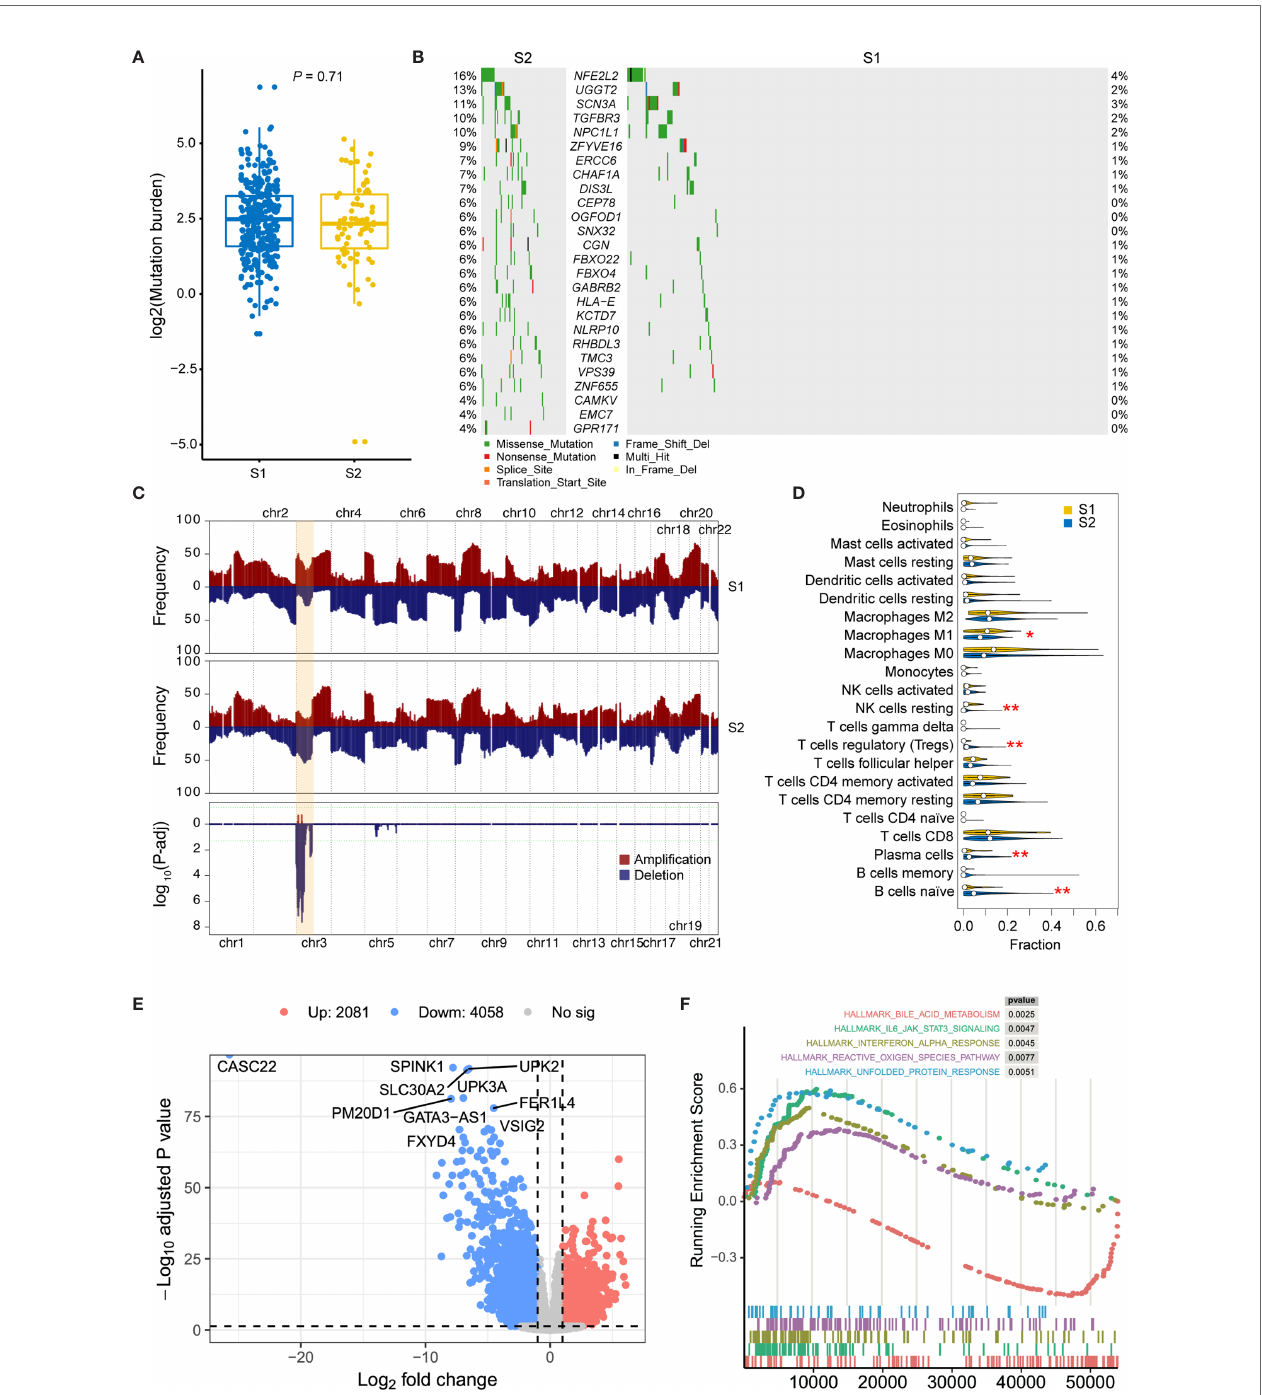
FIGURE 3 | Molecular comparison between two prognostic MIBC subtypes. (A) Mutation burden of MIBCs for each tumor was compared in S1 and S2. (B) Oncoplot shows differentially mutated genes between two MIBC subtypes. Chi-square test is performed, and genes with P < 0.05 are displayed. (C) Frequency comparison between S1 and S2 of genome-wide copy number gain and loss. The CNV frequencies along genome of S1 and S2 are shown in top and middle pattern, respectively. All ampli fi cations in MIBC cohort are shown in red, and all deletions are shown in blue. Chi-square test is performed for each cytoband, and the P -value distribution of each region was shown in the bottom module. Chromosome 3p, which contains all signi fi cant regions, is highlighted in orange. (D) Comparison of the immune cell compositions in S1 and S2. The immune cell contents were decomposed using CIBERSORT. Wilcox test is performed for each comparison, and signi fi cant entries are marked with asterisks (**P < 0.01; *P < 0.05). (E) Volcano plot shows the differentially expressed genes between high- and low-risk subtypes. Ten most signi fi cantly expressed genes are marked. (F) Top fi ve hallmark gene sets from gene set enrichment between high- and low-risk